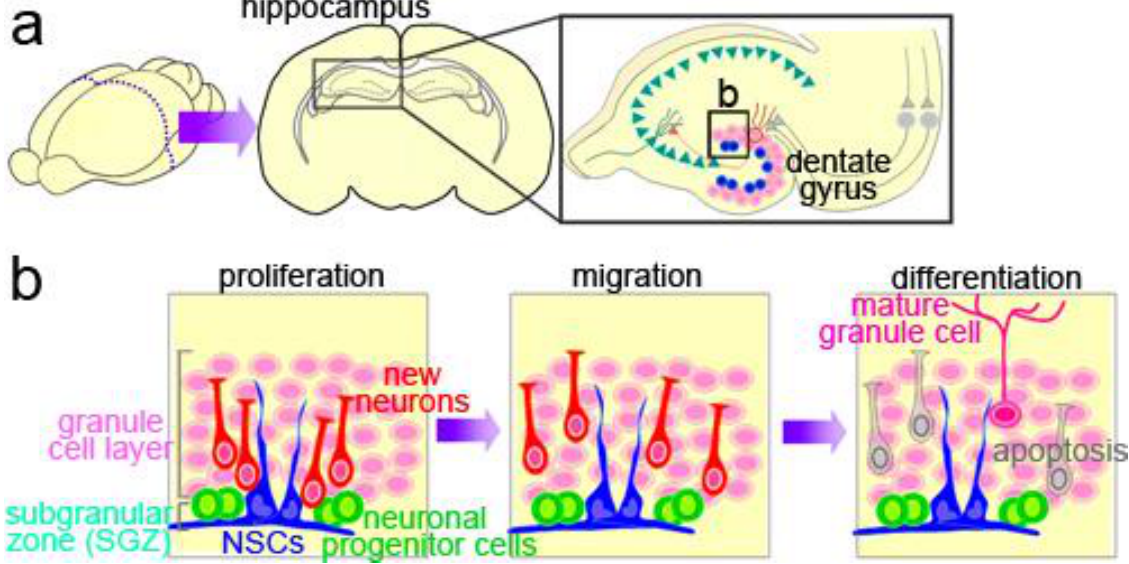
Figure 2. NSCs in the hippocampus. ( a ) Location, structure, and neuronal circuitry of the dentate gyrus in the hippocampus of the adult rodent brain. The input to the hippocampus is mainly provided by the entorhinal cortex through the perforant path (gray) to the granule cells (pink) in the dentate gyrus; ( b ) Neurogenesis in the dentate gyrus. NSCs (blue) and neuronal progenitor cells (light green) reside in the SGZ, where they proliferate, and generate immature new neurons (red) (left). The new neurons migrate into the granule cell layer (middle), where some of them differentiate into mature granule cells (pink), and the rest are eliminated by apoptotic cell death (gray)